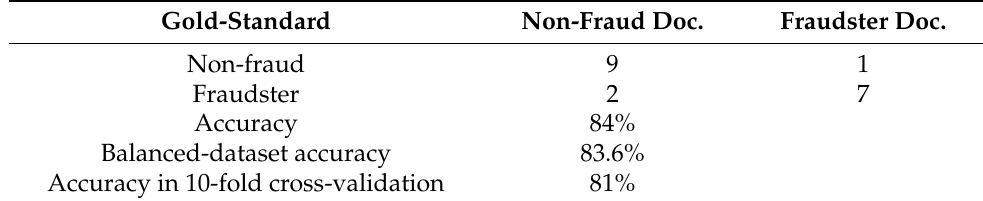
Table 5. Results of the SVM Classifier 80%–20% training-test scenario. Confusion matrix and